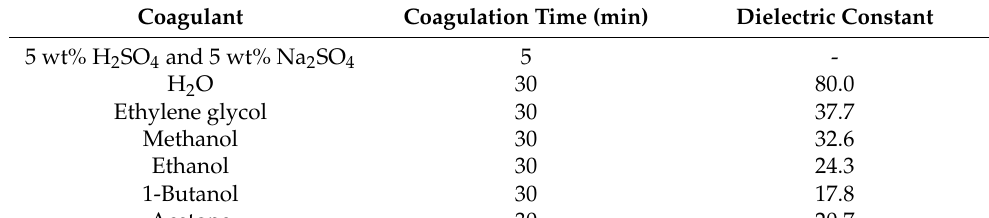
Table 1. Preparation conditions of regenerated cellulose film and polarity of coagulants.